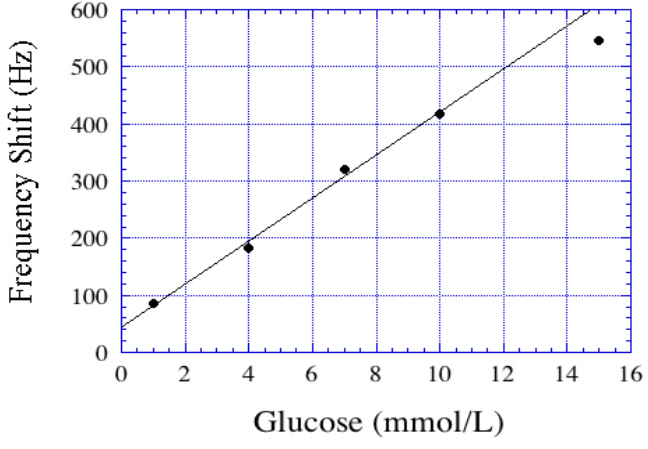
Figure 25. Shift in resonance frequency of a glucose oxidase (GOx) coated magnetoelastic sensor as a function of glucose concentration. Reprinted with permission from